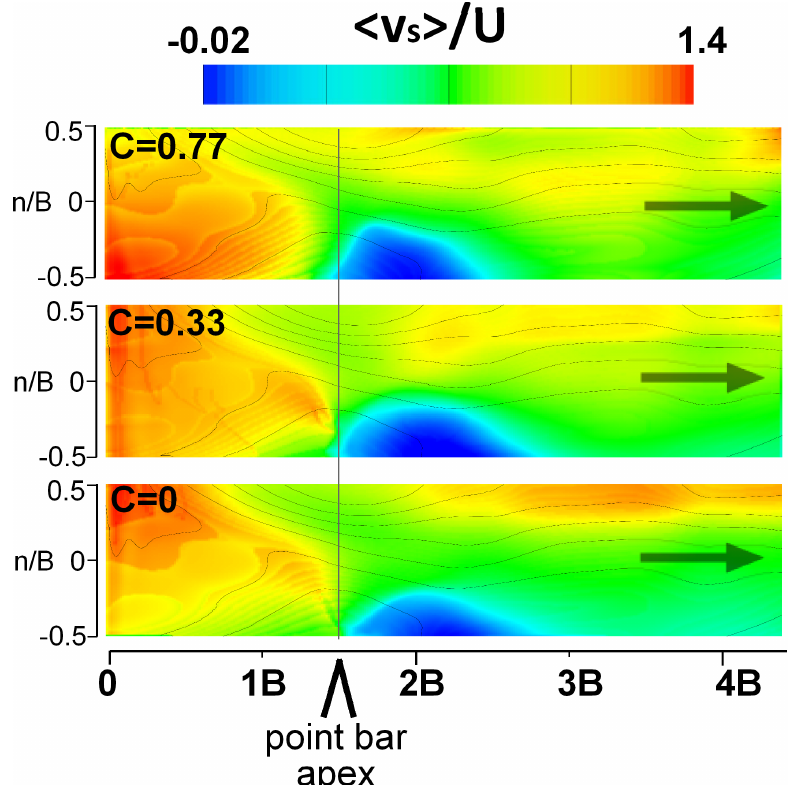
Figure 7. Normalized depth averaged streamwise velocity < v s > / U for channel curvature C = 0.77, 0.33, and 0 conditions.